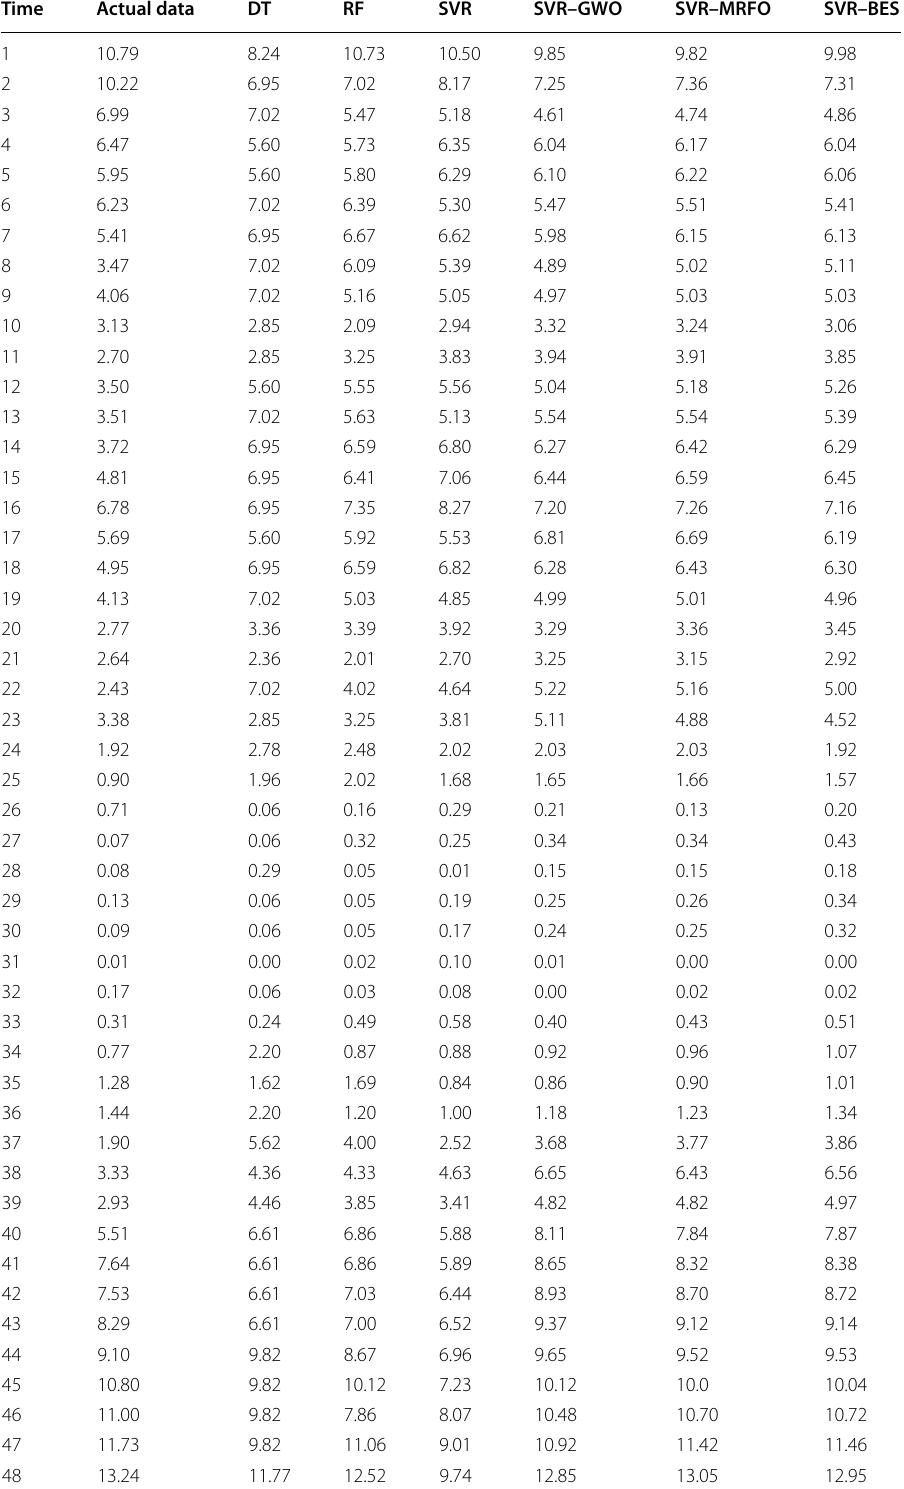
Table 2 Forecasting results of 08 and 09 December